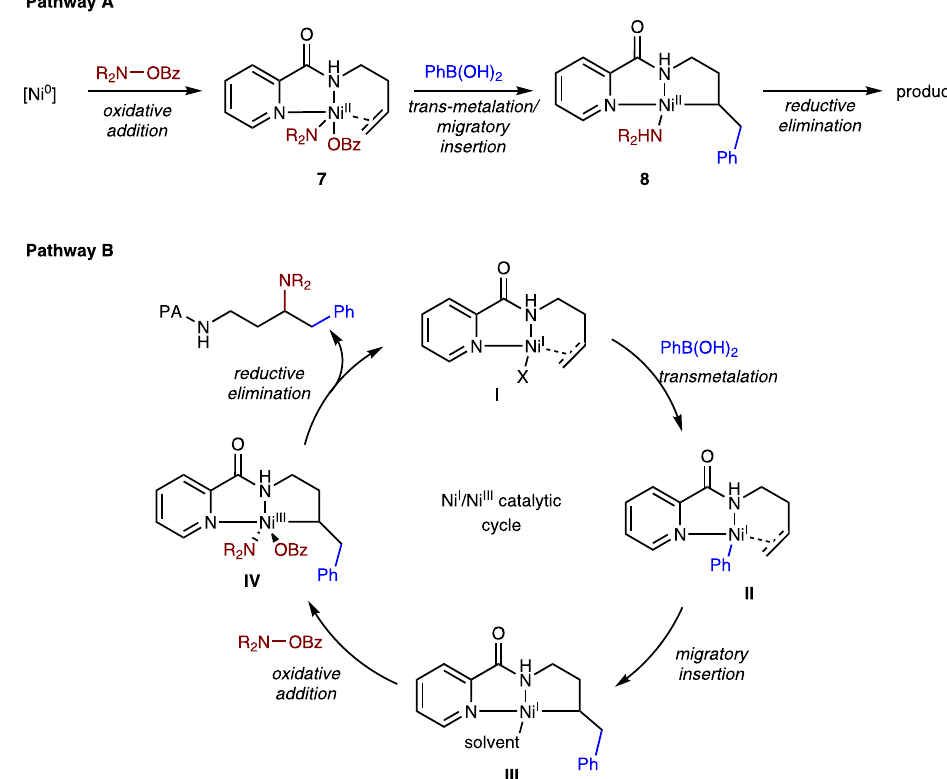
Fig. 8 Proposed mechanism. Two possible pathways for the Ni-catalyzed 1,2-arylamination of alkenyl amines.